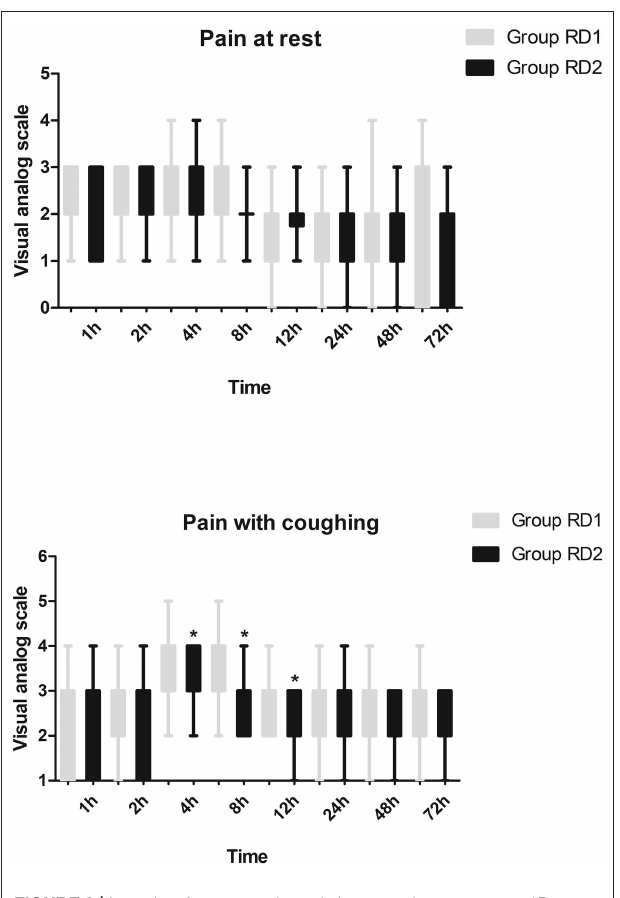
FIGURE 3 | Intensity of postoperative pain between the two groups. * P < 0.05 vs. RD1 group.